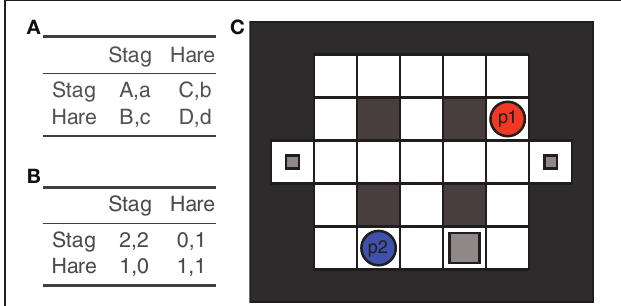
FIGURE 3 | The Stag Hunt game and its current neuroscientific implementation. Panel (A) depicts the stag hunt game in its general form according to which the following relation holds: A > B ≥ D > C . Panel (B) gives an example of the stag hunt’s payoff matrix. Panel (C) shows the Stag Hunt Game as implemented by Yoshida et al. (2008, 2010a,b). Analogous to the original description by—Jean-Jacques Rousseau, the stag yields a higher reward but can only be caught by both players’combined efforts, that is, by conjointly blocking the stag (big gray square) from two sides to prevent its escape. In this implementation of the game, the hares are realized as stationary objects (small gray squares), referred to as “rabbits.” This ensures that both players can easily and independently catch them. Rabbits only yield limited rewards. Additionally, the round is over when a hunter caught a rabbit. Similar to a board game players take turns moving their token between